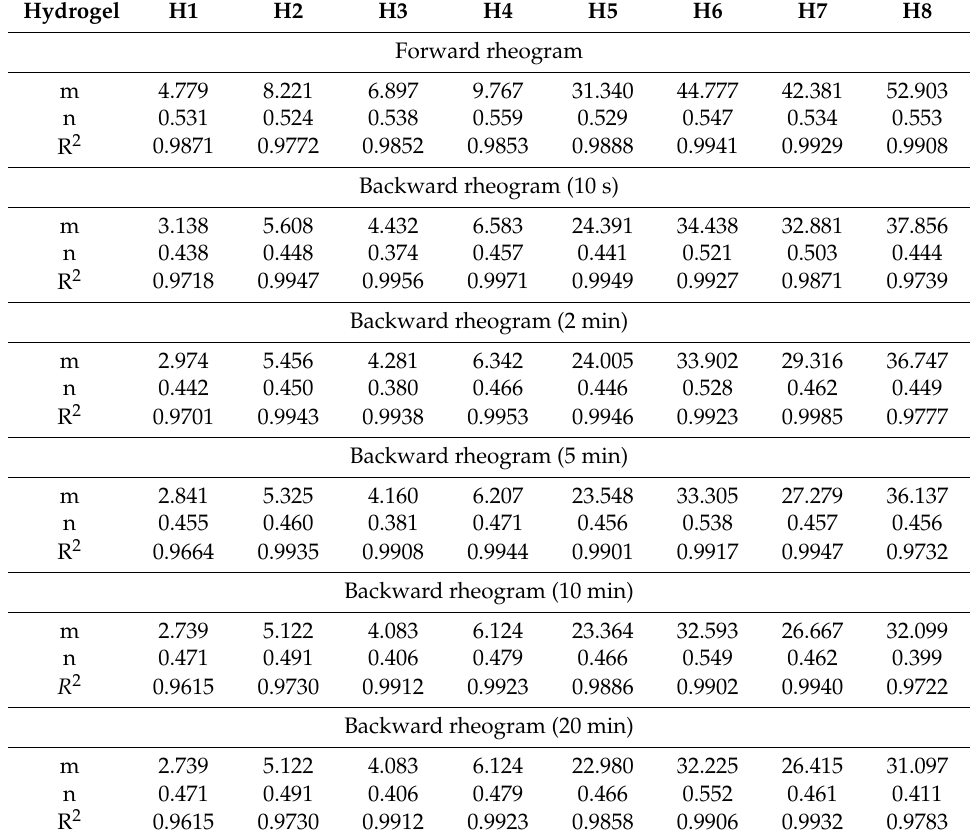
Table 3. Power law model parameters obtained in relation with forward and backward rheograms for hydrogels tested at 23 ˝ C.